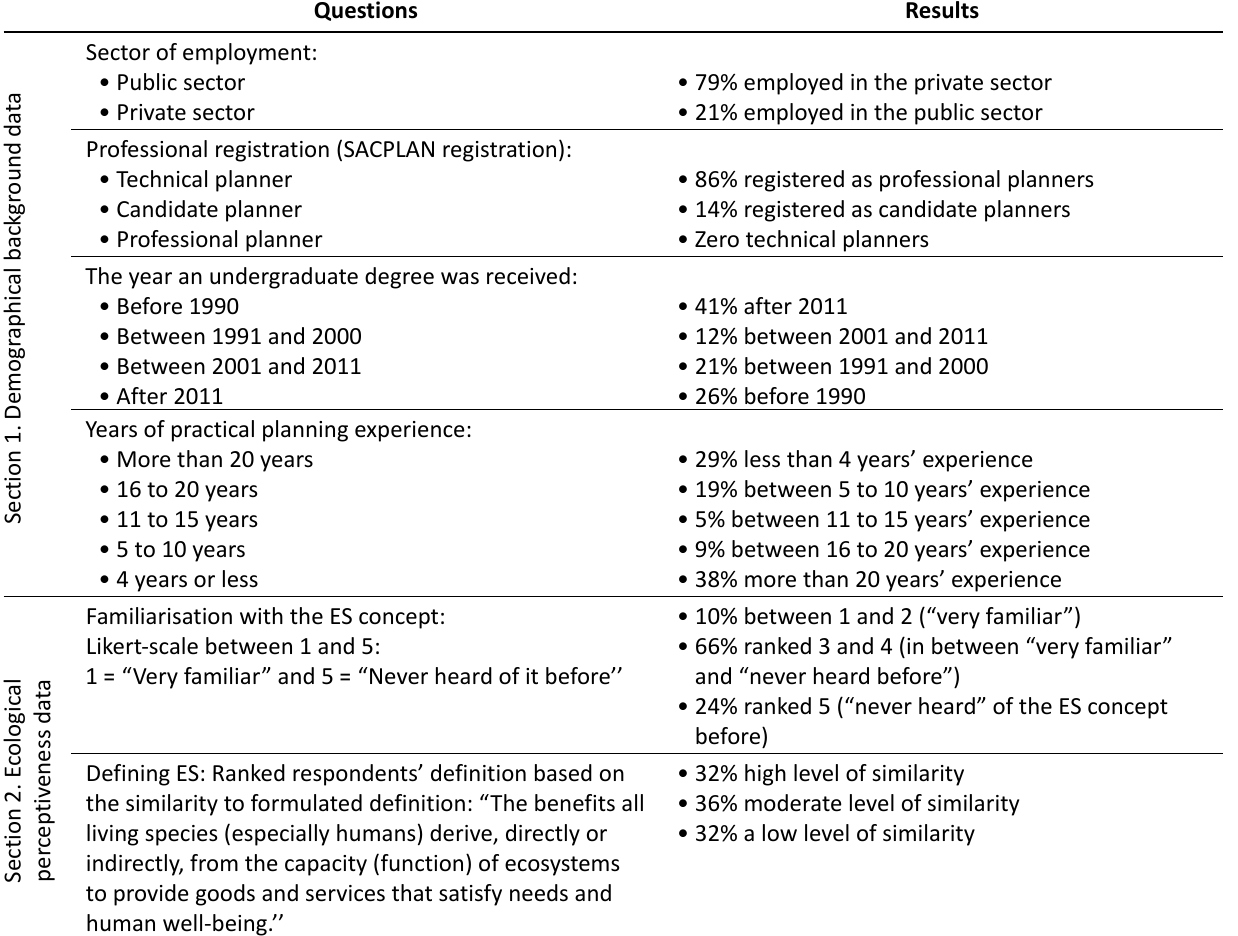
Table 1. Results of the online